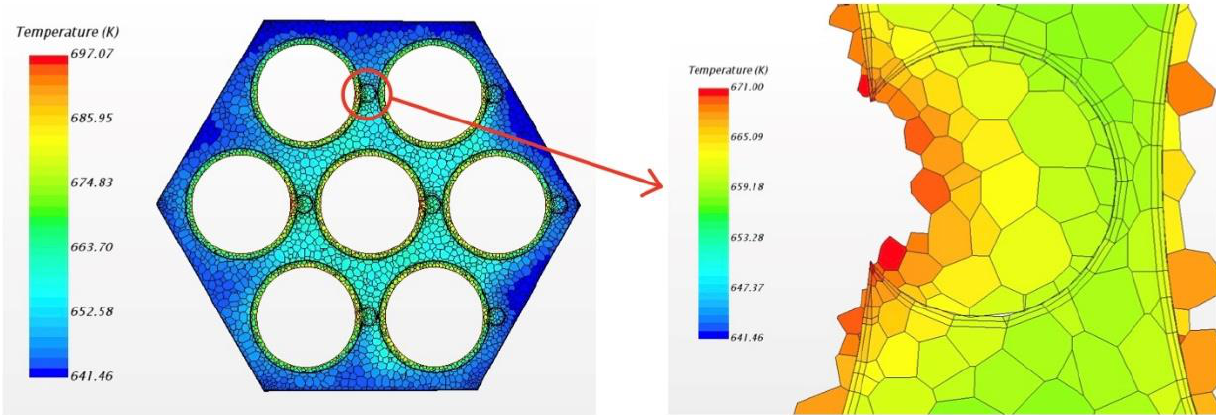
Figure 8. The temperature field of cross section and local magnification around wrapping wire.